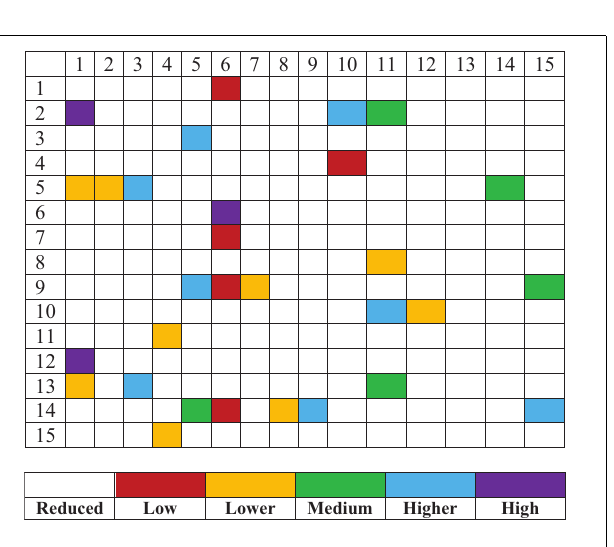
FIGURE 5 | Linguistic meaning of activated features of each